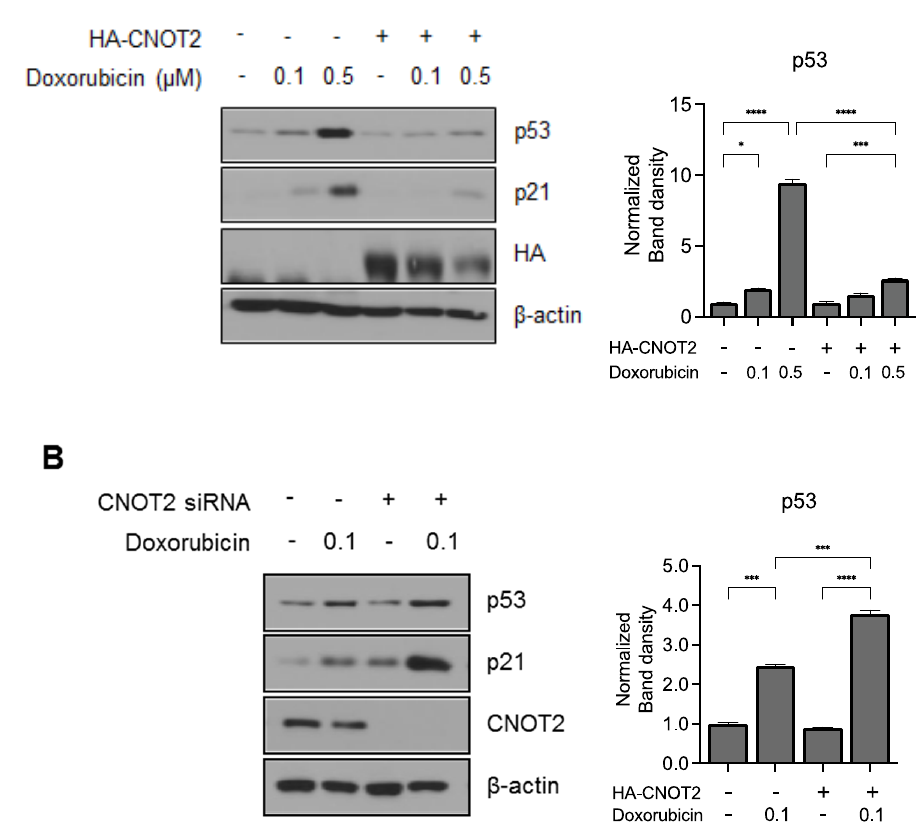
Figure 5. The increased expression of CNOT2 reduces p53 expression, and inhibition of CNOT2 further increases p53 expression due to DNA-damage drugs. ( A ) HCT116 p53+/+ cells were transfected with HA-CNOT2 or pcDNA for 48 h. After transfection, cells were treated with doxorubicin for 24 h. ( B ) HCT116 p53+/+ cells were transfected with scramble or CNOT2 siRNA for 48 h. After transfection, cells were treated with doxorubicin for 24 h. * p value * p < 0.05, *** p < 0.005, **** p < 0.001.